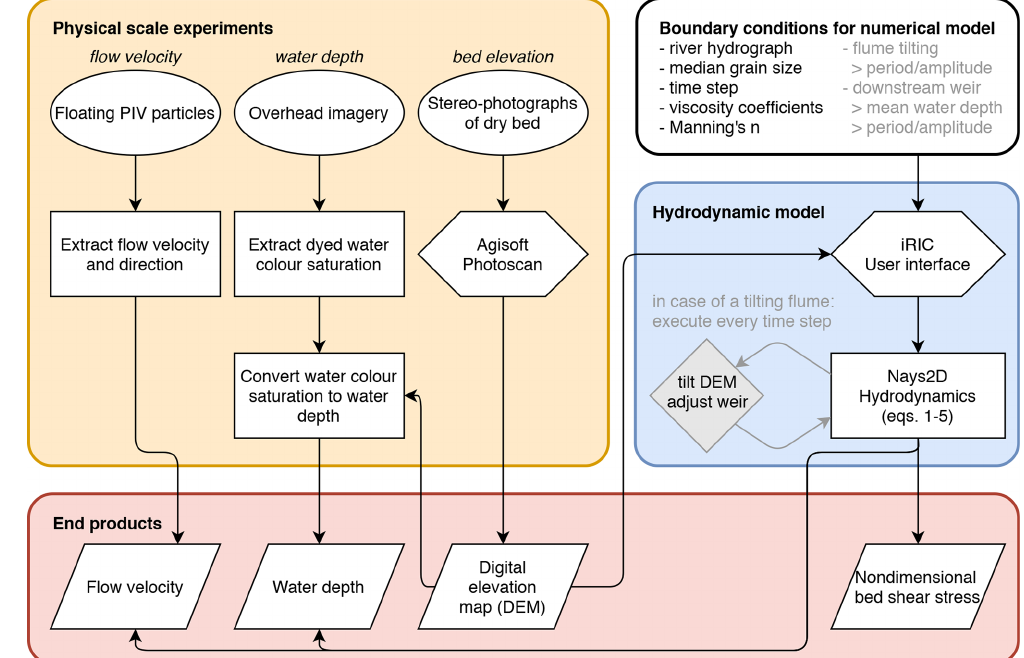
Figure 3. Workflow of integrating physical scale experiments and the numerical hydrodynamic model Nays2D to acquire water depth, flow velocity and sediment mobility maps (i.e. excluding point measurements). The DEM and corresponding boundary conditions are input to the model. Grey elements apply only to tilting flume experiments that simulate tidal systems. End products are on the bottom row and are indicators of hydrodynamics and morphological change. Table 2. Model settings and boundary conditions of the physical scale experiments (in italics) in Nays2D. The first block of parameters is retrieved from the experiments; the second block is user-defined. Parameter Unit Van Dijk et al. (2013a) Leuven et al. (2018) meandering/braided rivers